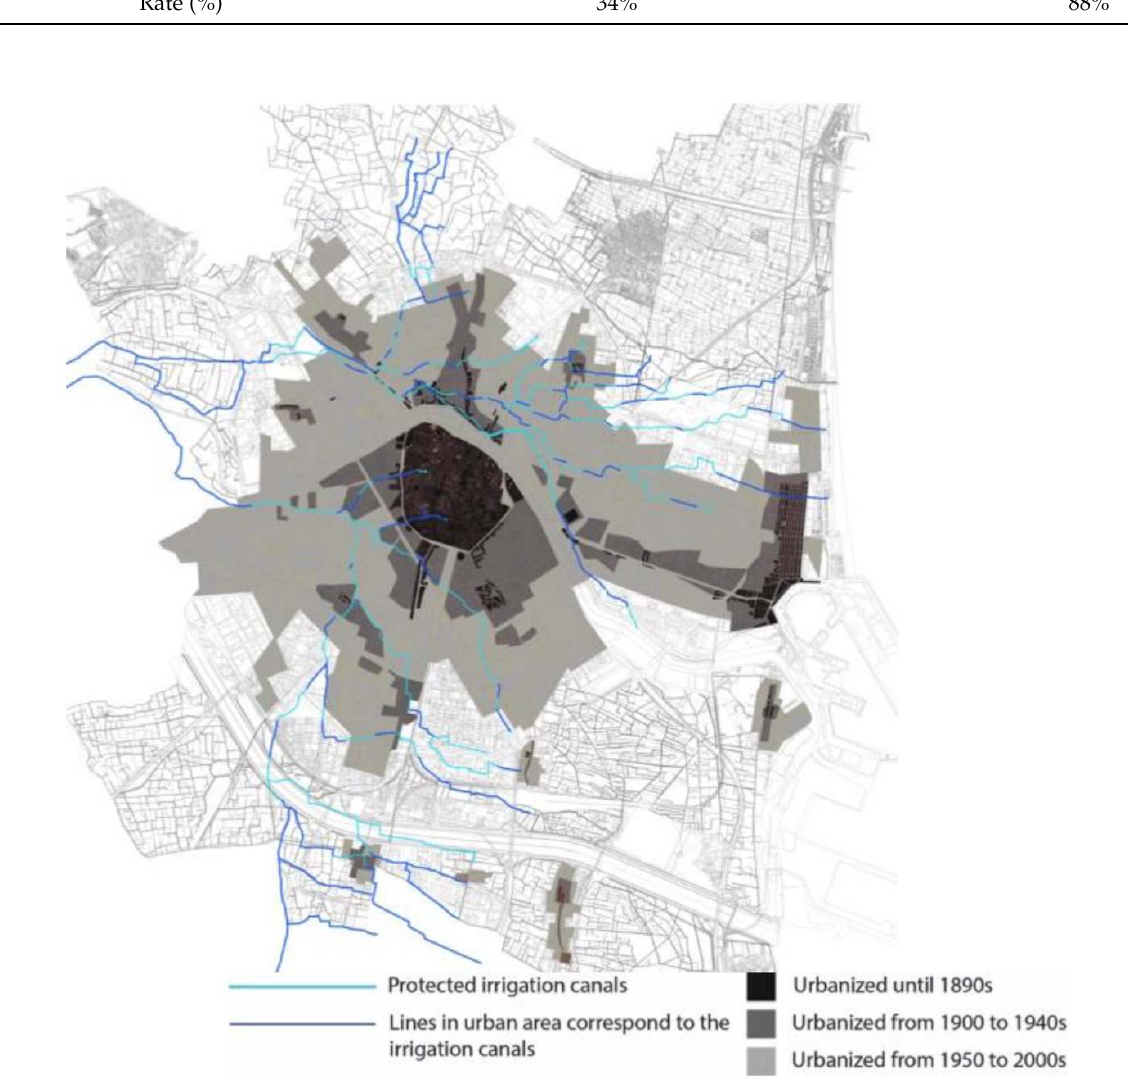
Figure 14. The inheritance of the irrigation canals and the phases of urbanization.